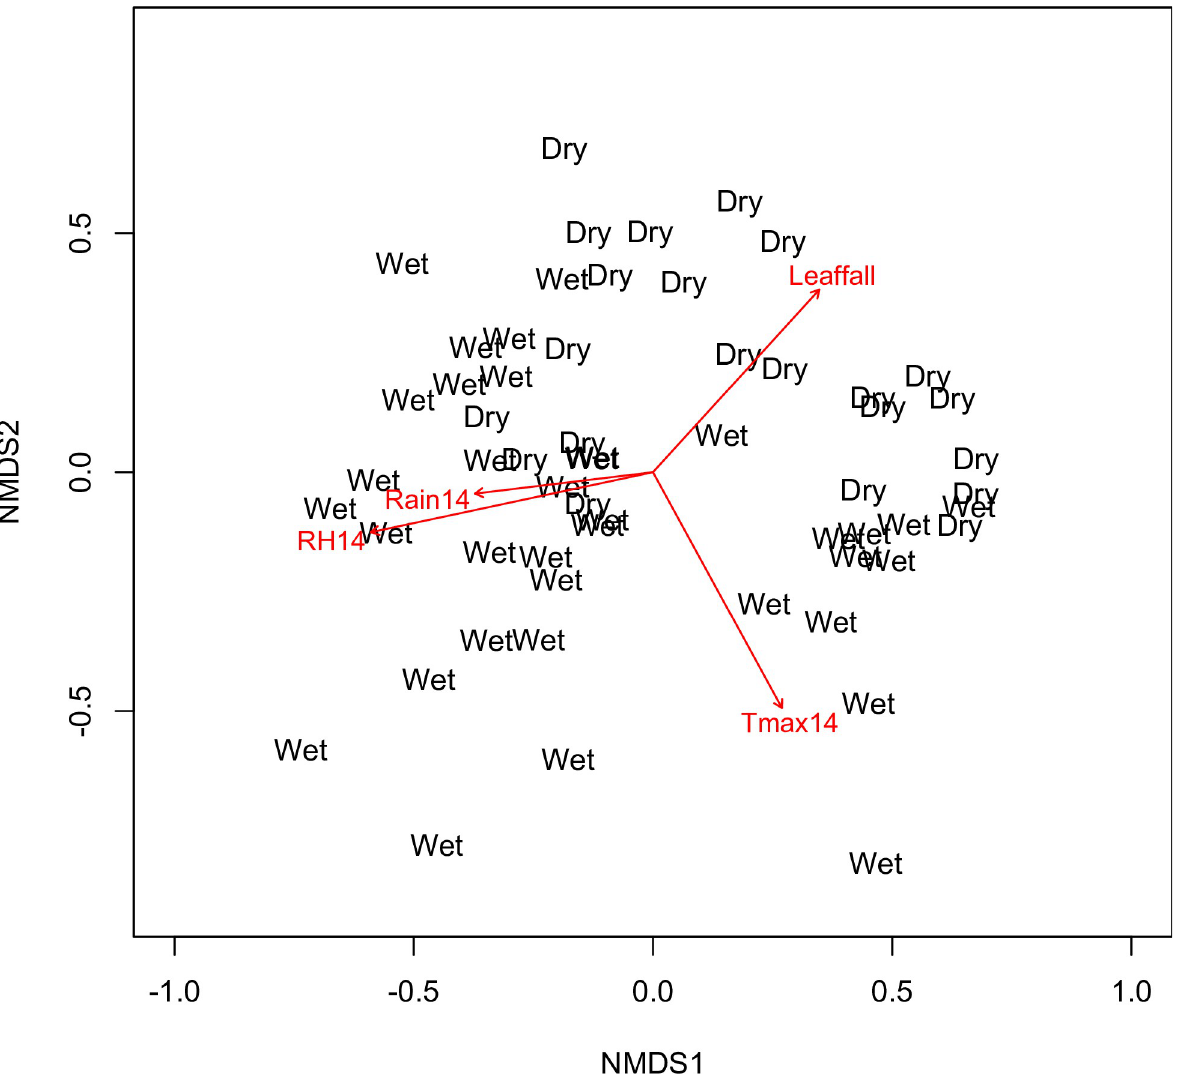
Fig 1. A Non-Metric Multidimensional Scaling (NMDS) analysis of our male ant community across seasons. The ordering of weekly samples in wet and dry seasons is based on Bray-Curtis distances. Environmental variables in Table 2 were fitted to the NMDS axes using Pearson correlations. For simplicity, only Rain, RH, Tmax (all accumulated from the last 14 days before collection), and litterfall are included in the figure. Stress = 0.14 for a three-dimensional ordination.